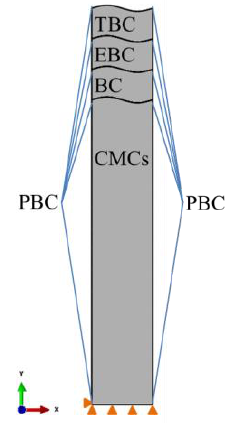
Figure 2. Geometric model and mechanical boundary conditions of CMCs coatings.